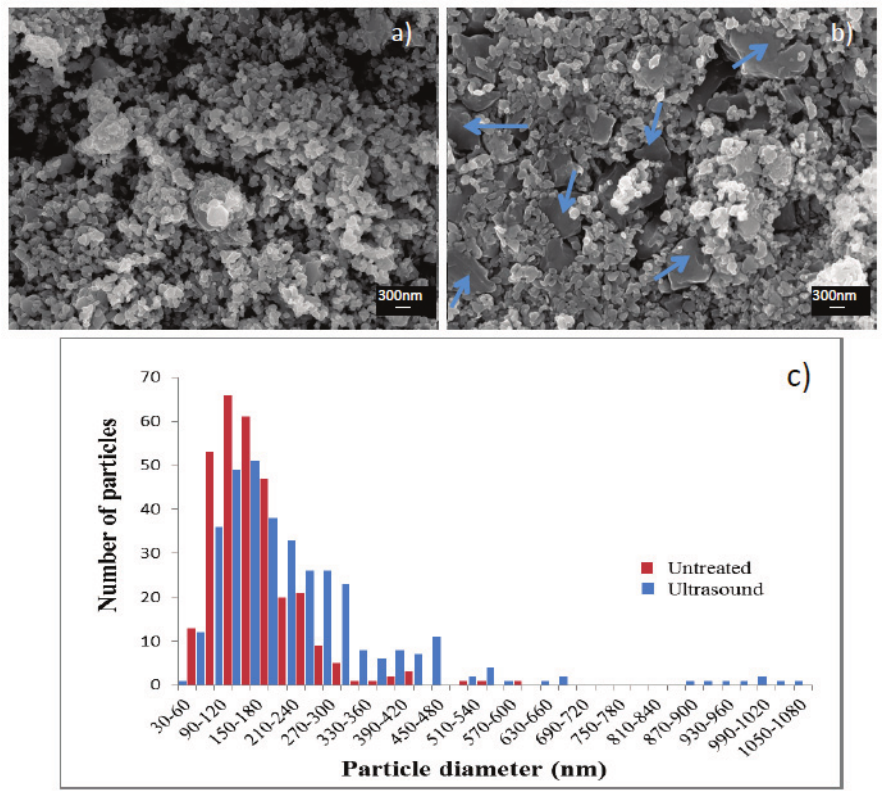
Figure 3. SEM micrographs of ( a ) untreated particles, ( b ) samples treated with ultrasonic horn during 3 h at 20% amplitude (17 µpp). Note the appearance of layered particles of much larger dimensions than original spheroids; ( c ) Particle diameter comparison between the two